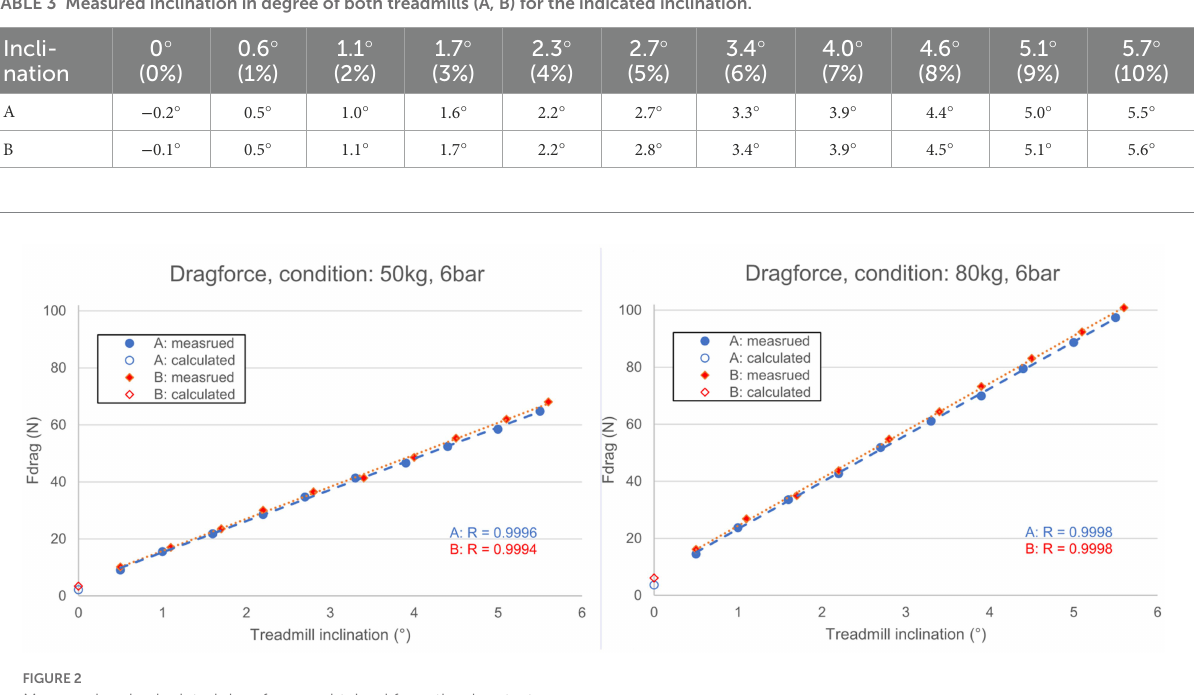
Cosmos Saturn Treadmills, the maximal difference was 0.8% of the intended velocity. Regarding inclination, de Groot et al.